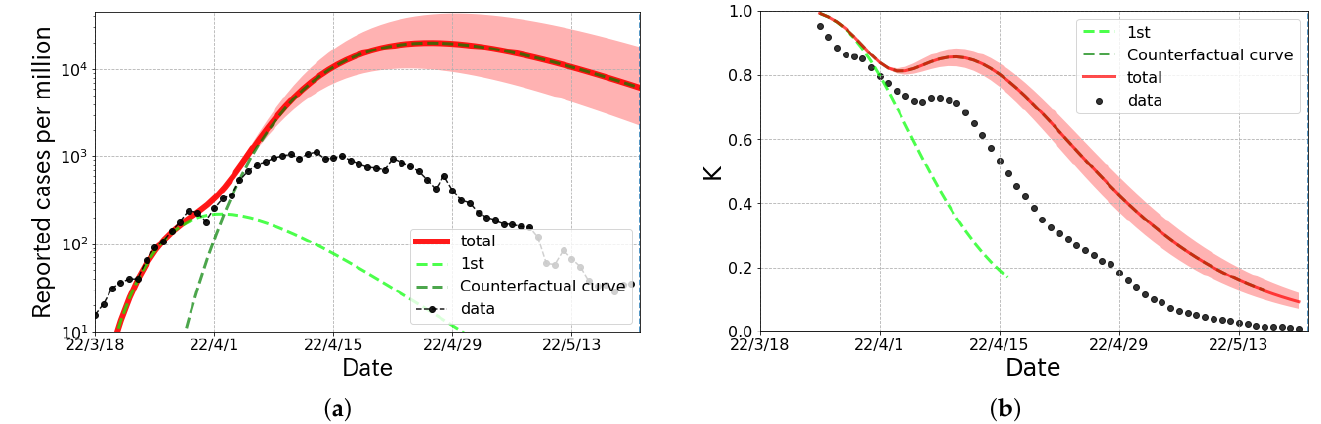
Figure 5. The logarithmic plot and the K-value of the counterfactual hypothesis curve in Shanghai. ( a ) The reported cases per million and the counterfactual curve (solid line) which is drown by changing the k in the second partial wave from 0.891 to 0.920, which is the typical value in Japan [17,18] ( b ) The observed data and the counterfactual curve of the K-value. The red bands stand for the fluctuations with the ± 0.05 changes in k